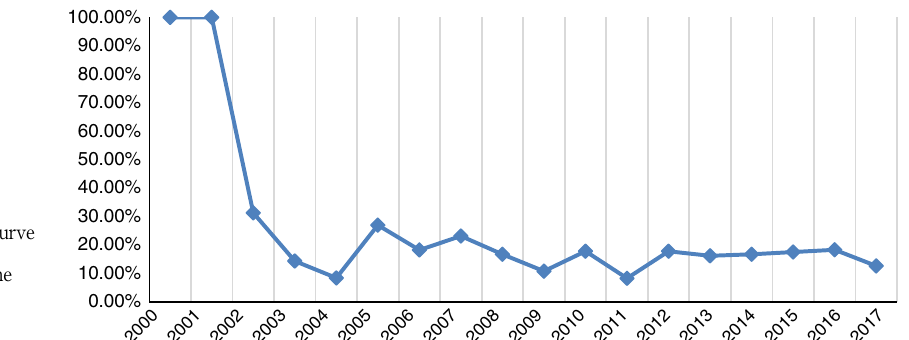
Figure 5. The growth rate